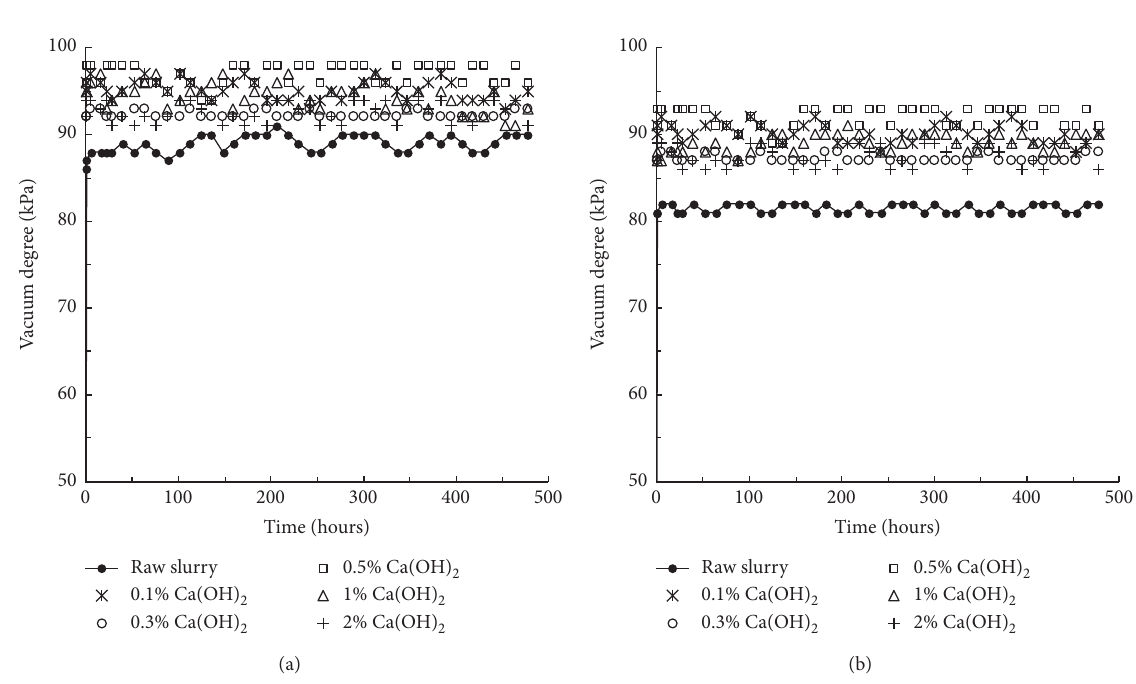
Figure 3: Vacuum degree versus time. (a) Top. (b)